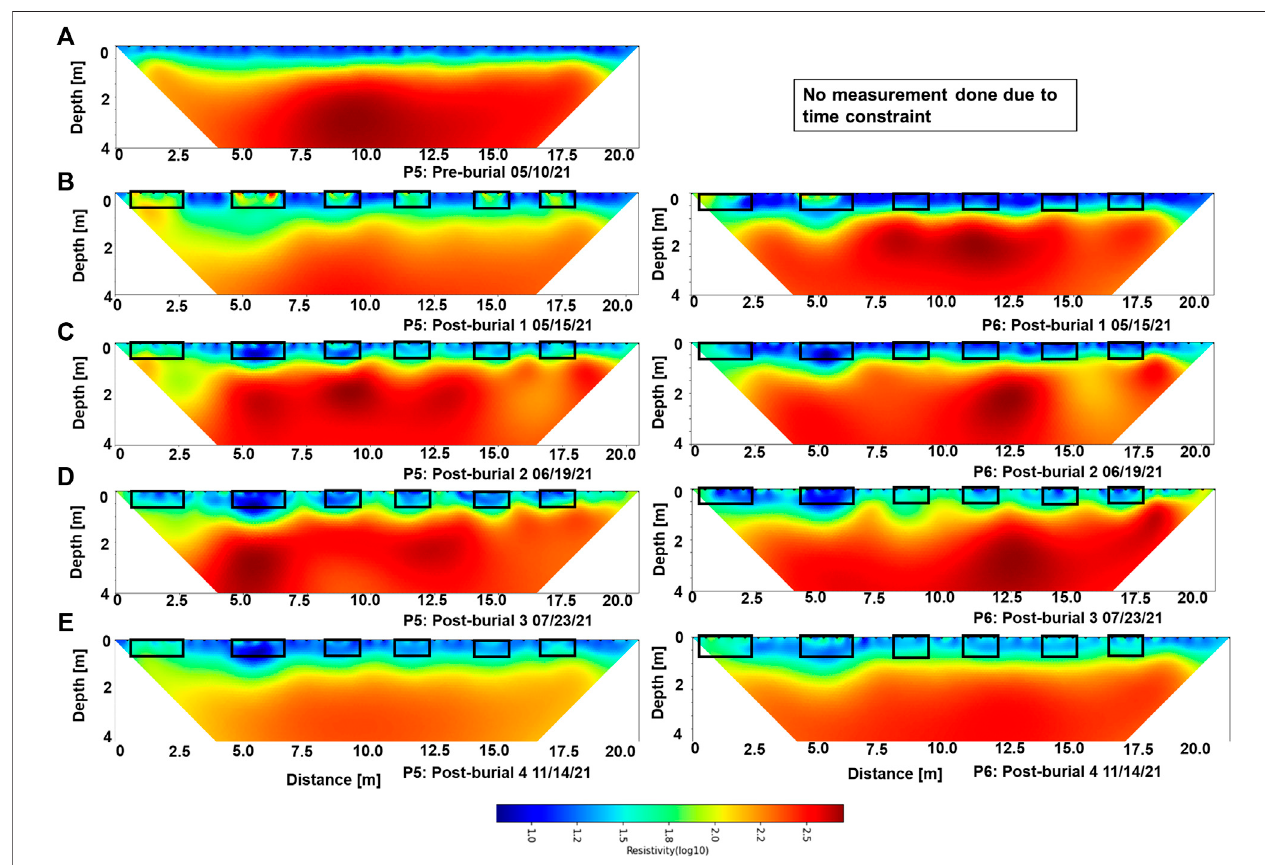
FIGURE 6 | 2D distribution of electrical resistivity across graves for pro fi les 5 (left) and 6 (right). Five different measurements were conducted (A) prior to burial, (B) 2 days after burial, (C) 1 month after burial, (D) 2 months after burial, and (E) 6 months after burial.